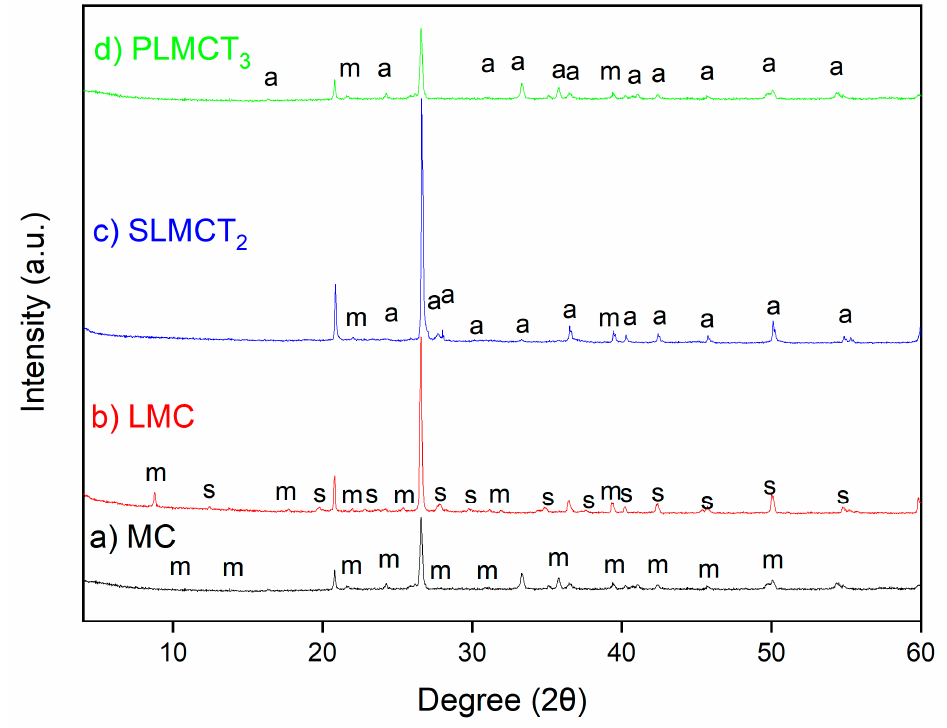
Figure 2. XRD patterns of the muscovite composites: ( a ) raw muscovite MC, ( b ) iron/manganese muscovite/sodalite LMC, ( c ) monolith muscovite/analcime SLMCT 2 and ( d ) pellets muscovite/analcime composites PLMCT 3 . Nomenclature: m (muscovite), s (sodalite) and a (analcime).